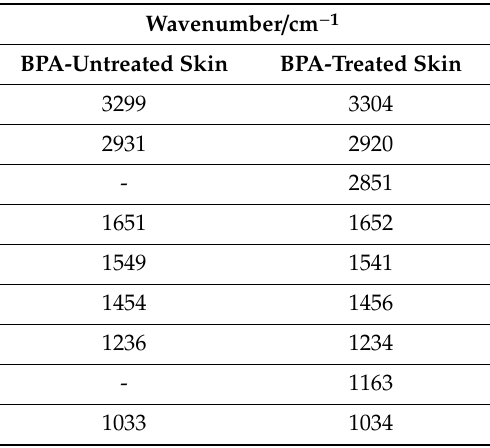
Table 15. Wavenumbers of infrared radiation absorption in the case of BPA.